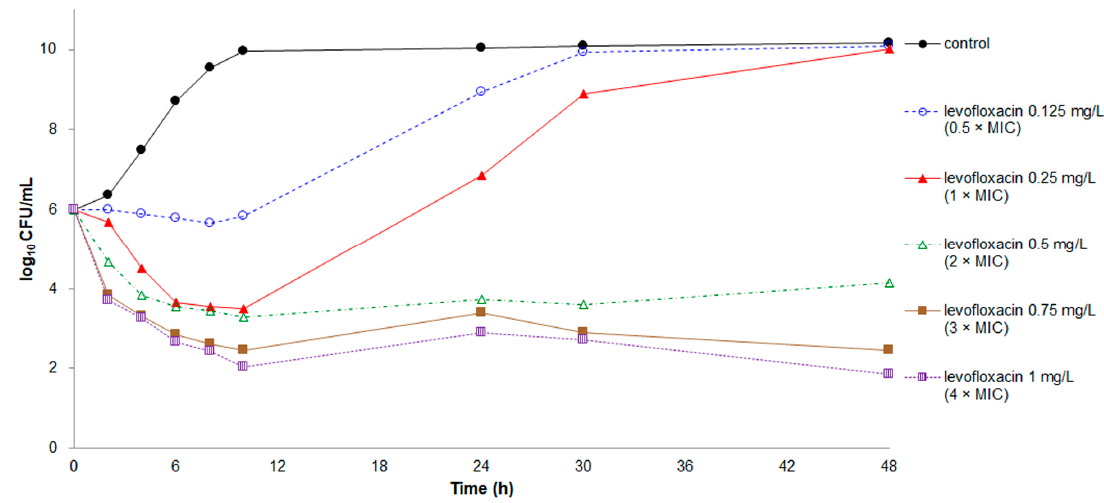
Figure 4. Time-kill assays for levofloxacin against E. anophelis strain ED853-49. Data points represent the mean of three experiments. MIC of levofloxacin = 0.25 mg/L.